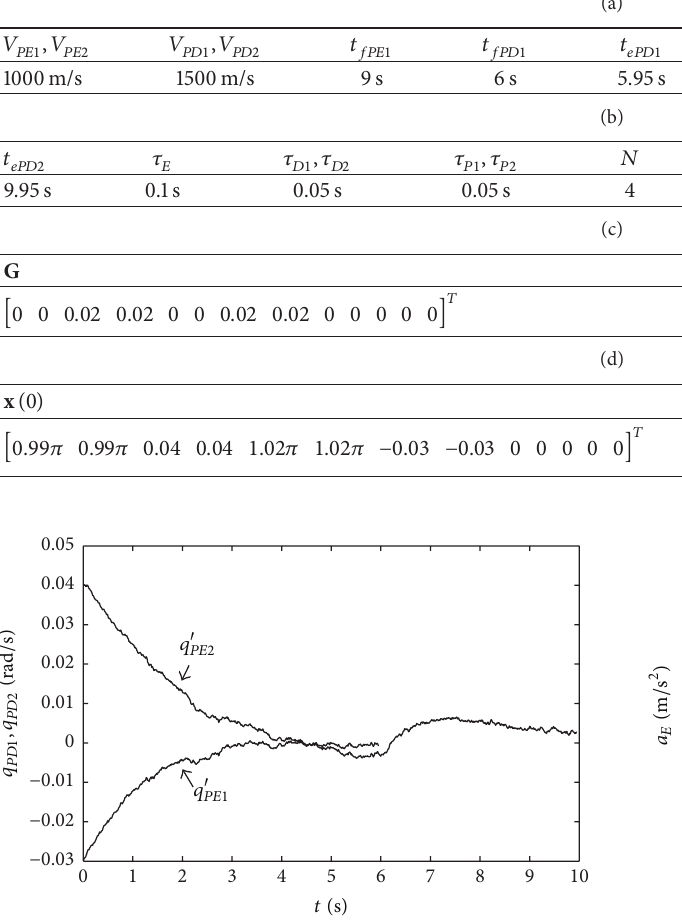
Table 4: Simulation parameters of multi-Defender versus multi-Pursuer case.